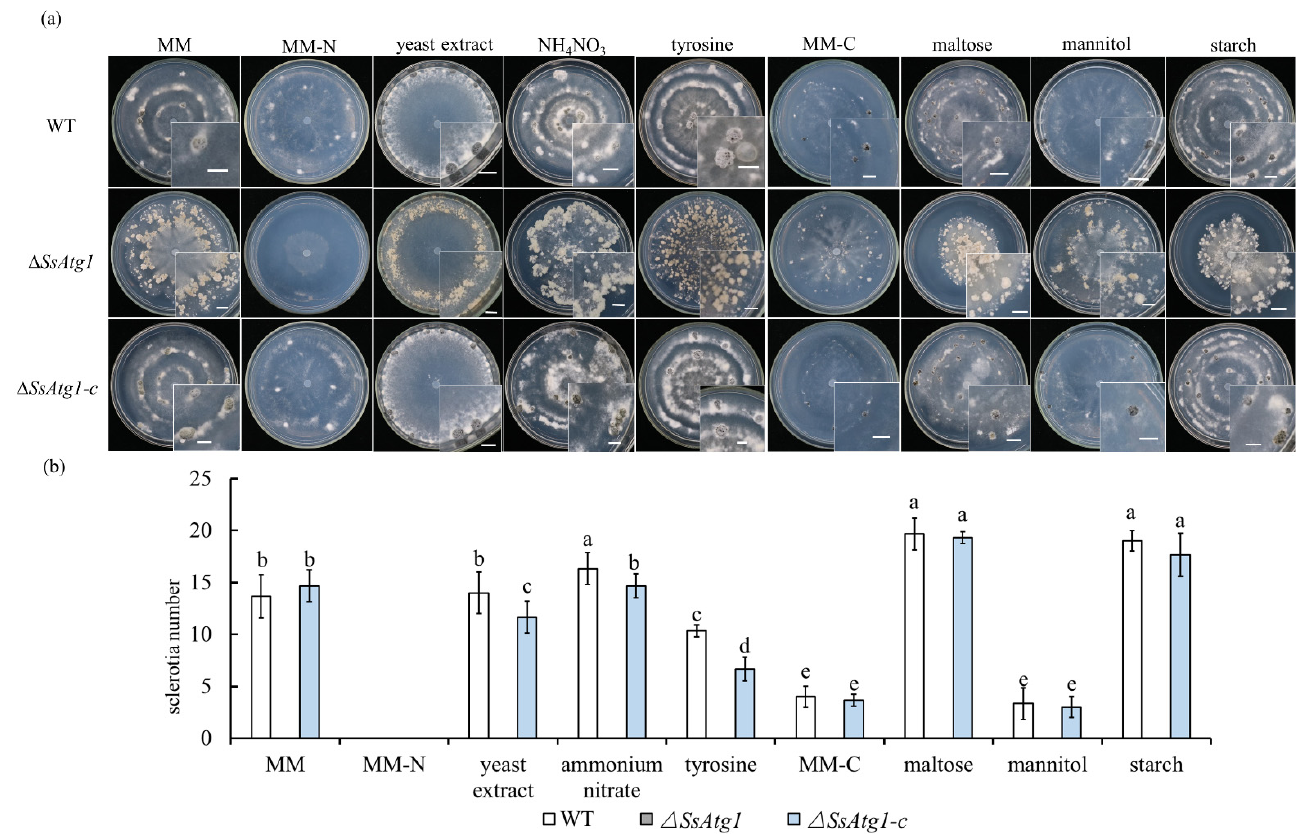
Figure 4. Role of SsAtg1 in response to nutritional stress . ( a ) Colony morphology of wild type and ∆ SsAtg1 and the genetically complemented strain on different growth media. Strains were inoculated on MM replaced with indicated C sources and N sources. Scale bar = 0.5 cm. ( b ) Sclerotia number of ∆ SsAtg1 on different growth media. Colony morphology and sclerotia number were recorded after 4 weeks. The letters indicated significant differences (p < 0.05), error bars represent standard deviation from the mean.